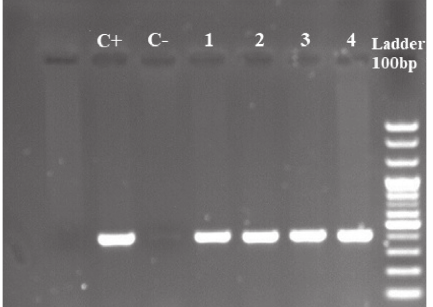
Figure 3: PCR products of mphA gene among Shigella clinical strains. Lane 2, positive control ( S. Sonnei accession number: OL310860); lane 3, negative control; and lane 4, 5, 6, and 7 in- cluding sample 1 to 4, Shigella isolates harboring mphA